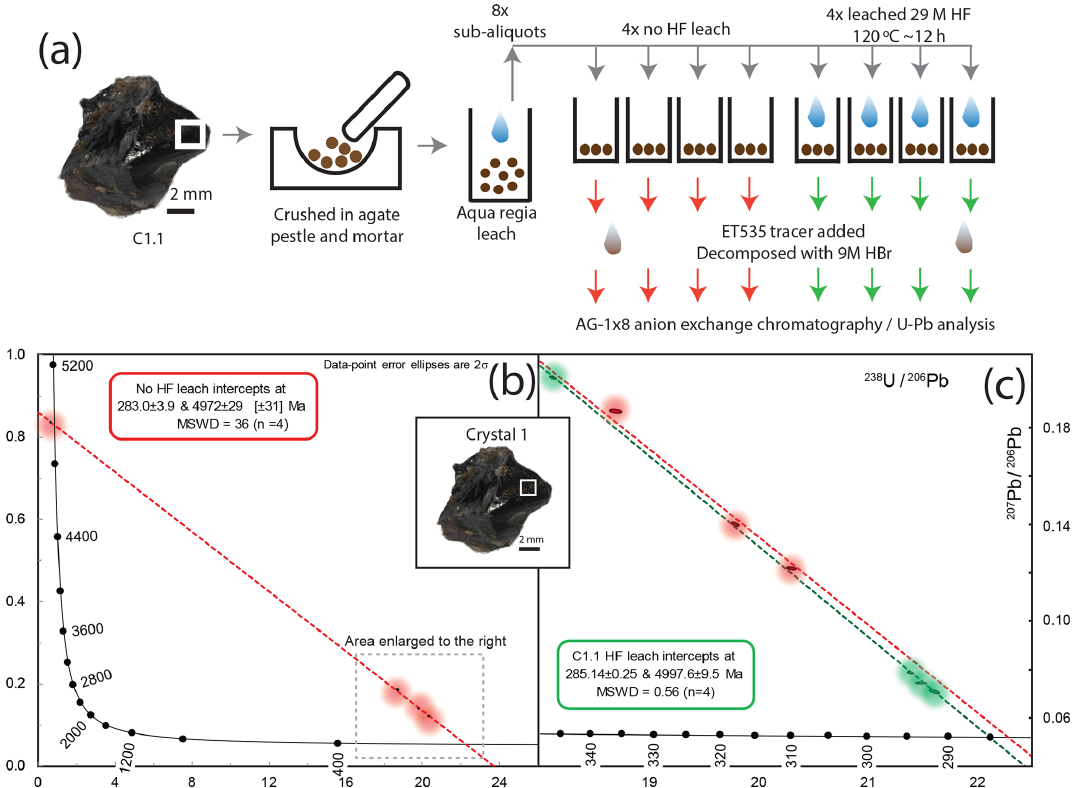
Figure 7. (a) Schematic workflow of sampling and acid pretreatment of C1.1 cassiterite. (b) T–W plot and regression of non-HF-leached sub-aliquots; individual data points are highlighted by a coloured halo due to their size at the scale of spread in the data. (c) T–W plot and regression of C1.1 HF-leached sub-aliquots (green) compared to the data and regression of non-HF-leached (red) sub-aliquots. Data are highlighted by a coloured halo due to their size at the scale of spread in the